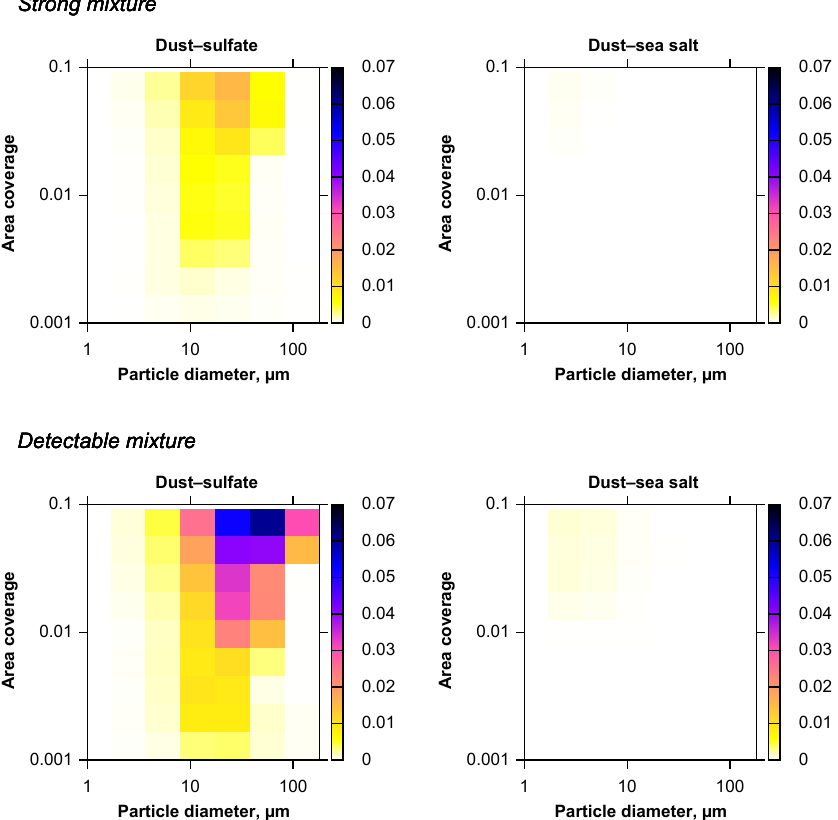
Figure 8. Upper 95% quantile of the fractions of internally mixed particles due to coincidental mixing on the substrate (color scale), for a dust–sea salt–sulfate system with measured composition and CV-ground size distribution. Strong mixture refers to a minimum particle volume fraction of the other component of 20%, detectable mixture refers to 1%. Mixing compounds are given on top of each graph. Practically, sulfate–sea salt and ternary mixtures do not form coincidentally.